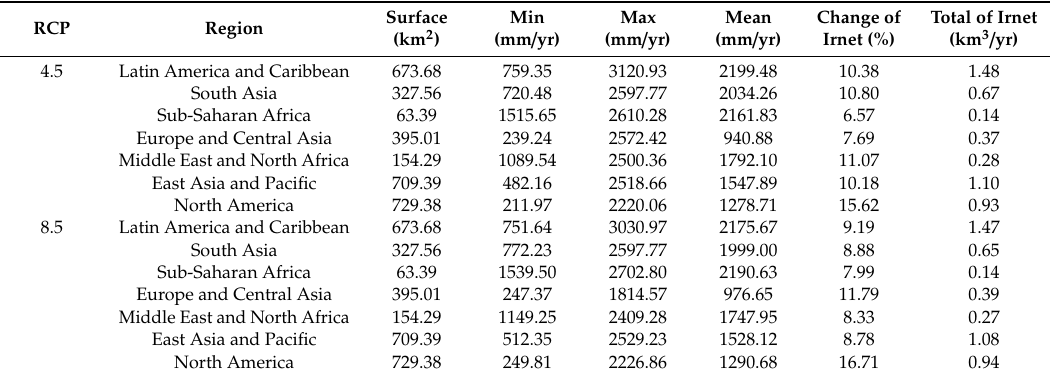
Table 2. CSIRO regional net irrigation